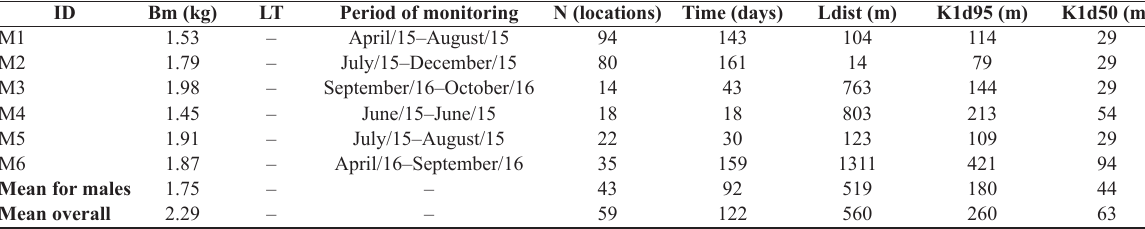
Table 2. Distance travelled by radio-tracked Phrynops geoffroanus males at the studied area (Campo Grande, MS, Brazil). ID – individual; Bm – body mass; LT – locations recorded in terrestrial habitat; N – number of recorded locations; Time – number of days elapsed from first to last recorded location; Ldist – minimum linear home range; K1d95 – 1D Kernel 95%; K1d50 – 1D Kernel 50%; kg – kilograms; m – meters; Mean overall – average for females and